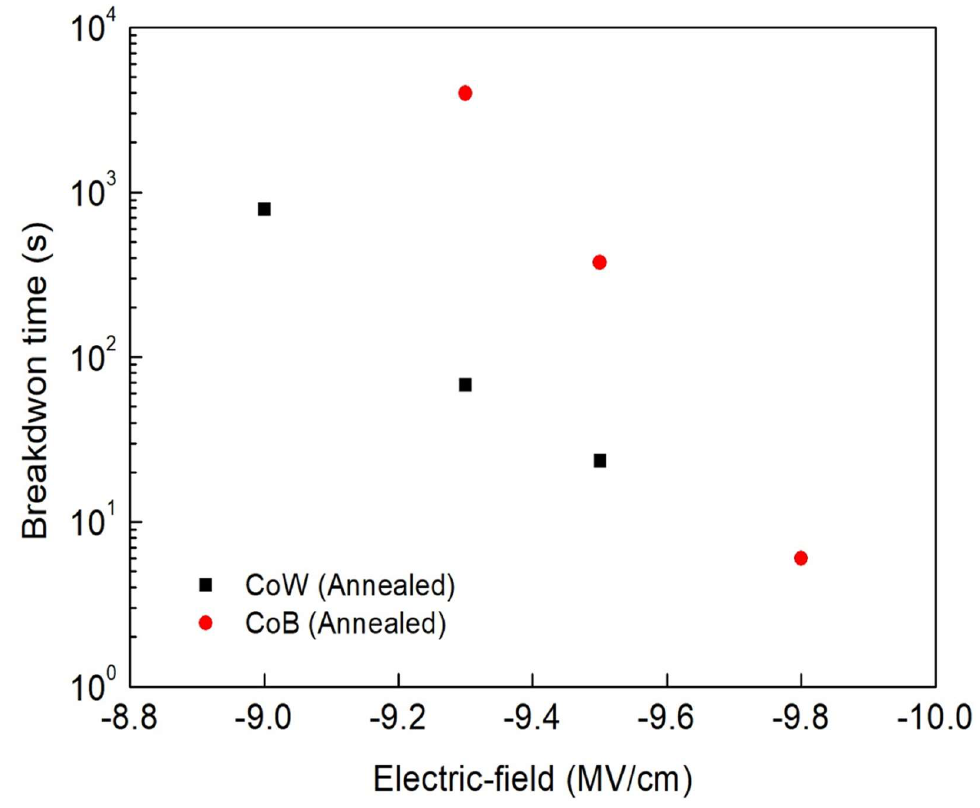
Figure 9. Comparison of breakdown times for annealed CoW-gate and CoB-gate MIS capacitors as a function of stressing field.